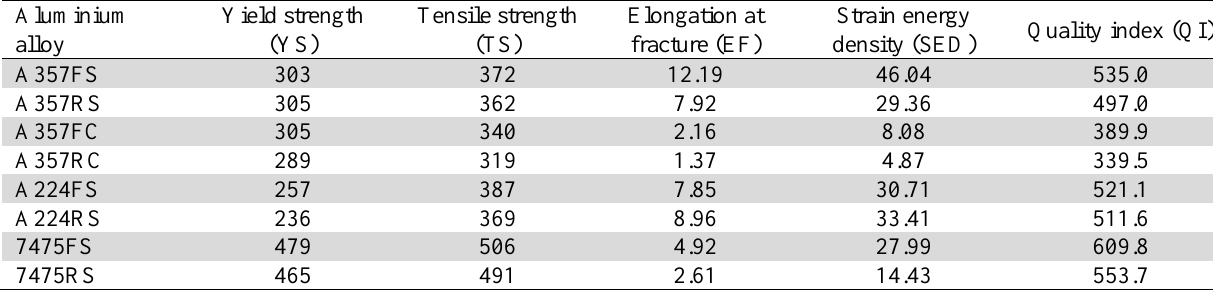
Mechanical properties of aluminium alloys